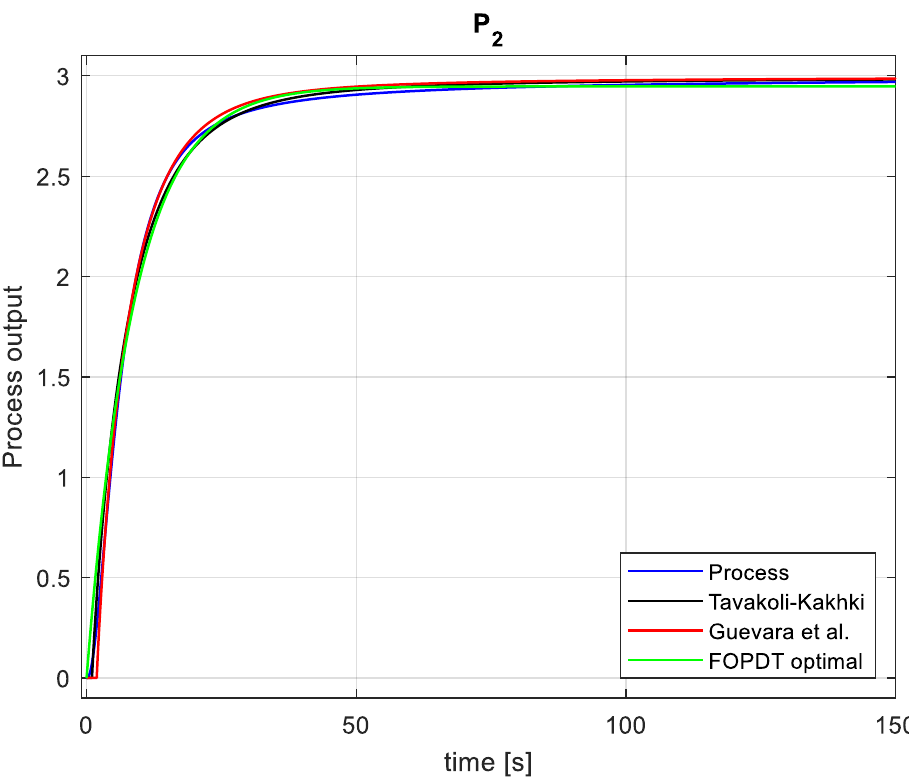
Figure 18. Step response of the FFOPDT model obtained using methods proposed by Tavakoli- Kakhki [31] and by Guevara [34], respectively, the step response of the optimal FOPDT model, for process P 2 and process reaction curve.